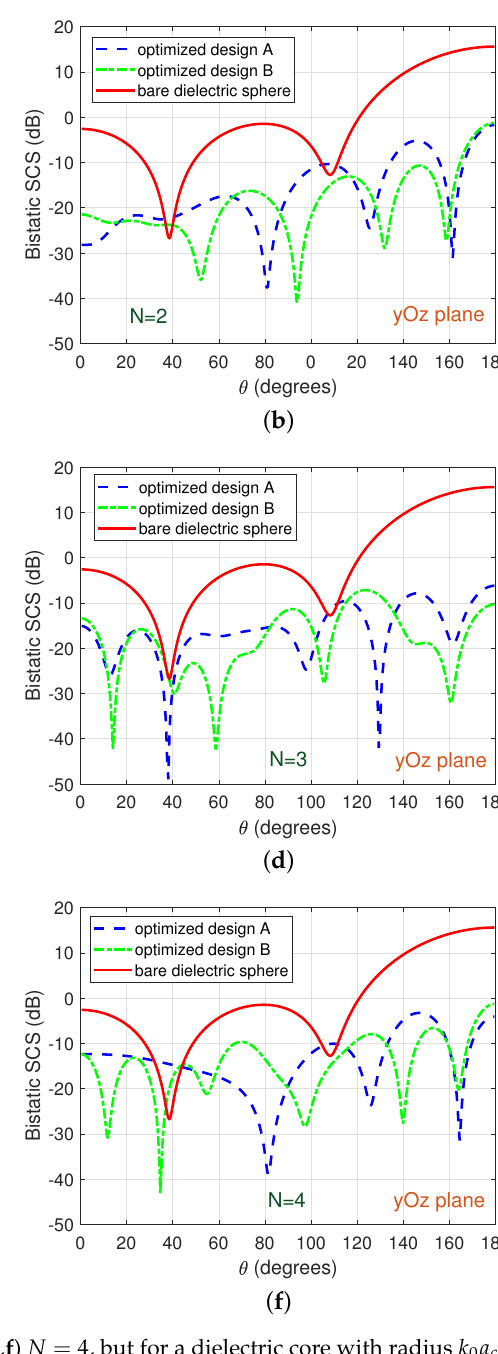
Figure 8. As in Figure 7 with ( a , b ) N = 2, ( c , d ) N = 3, and ( e , f ) N = 4, but for a dielectric core with radius k 0 a c = π . The values of the optimization variables for designs A and B are given in Table A6 of the Appendix